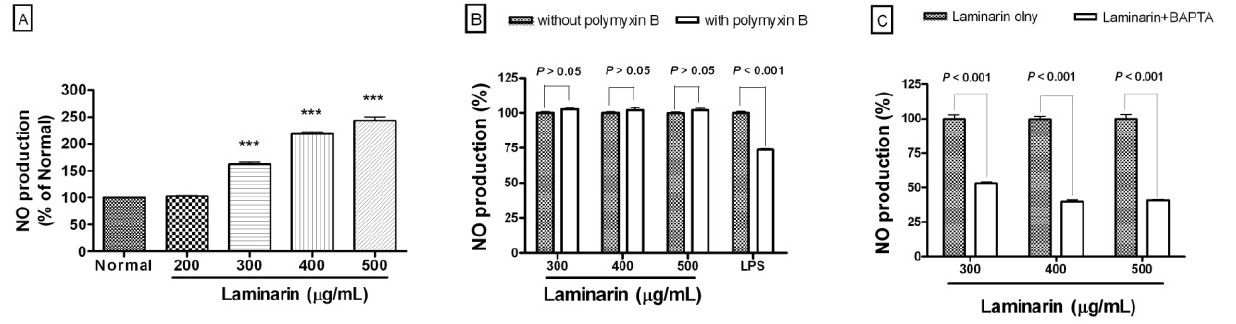
Figure 3. Effects of laminarin on NO production in RAW 264.7 mouse macrophages. After 24 h incubation with laminarin, NO production in RAW 264.7 was measured by a Griess reaction assay. The normal group (Normal) was treated with media only. Polymyxin B (0.5 µg/mL), an inhibitor of lipopolysaccharide (LPS; 1 µg/mL), did not show the significant effect on laminarin-induced NO production ( A and B ), whereas laminarin-induced NO production was significantly inhibited by intracellular calcium chelator, BAPTA-AM (BAPTA; 10 µM) ( C ). Values are the mean + SEM of three independent experiments. *** p < 0.001 vs.